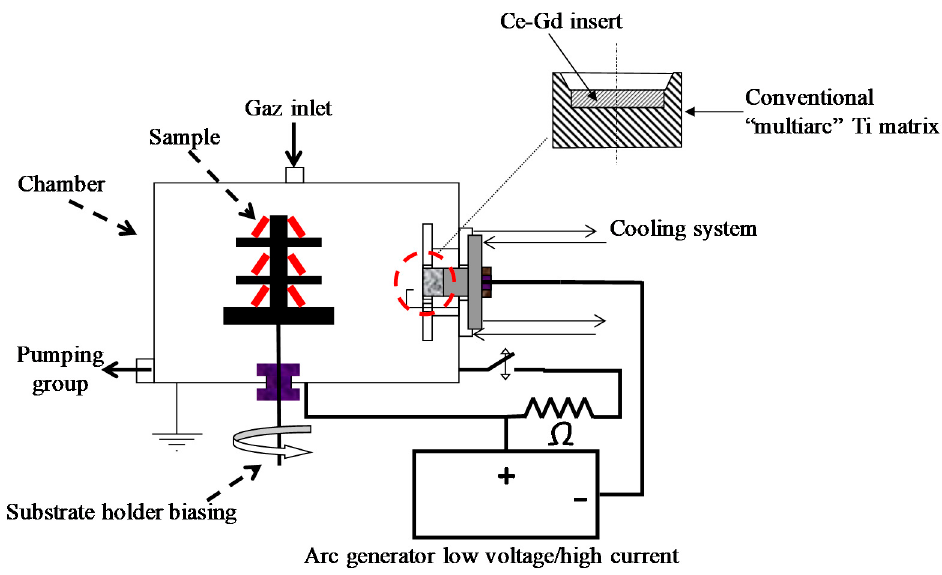
Figure 1. Scheme of the experimental device.